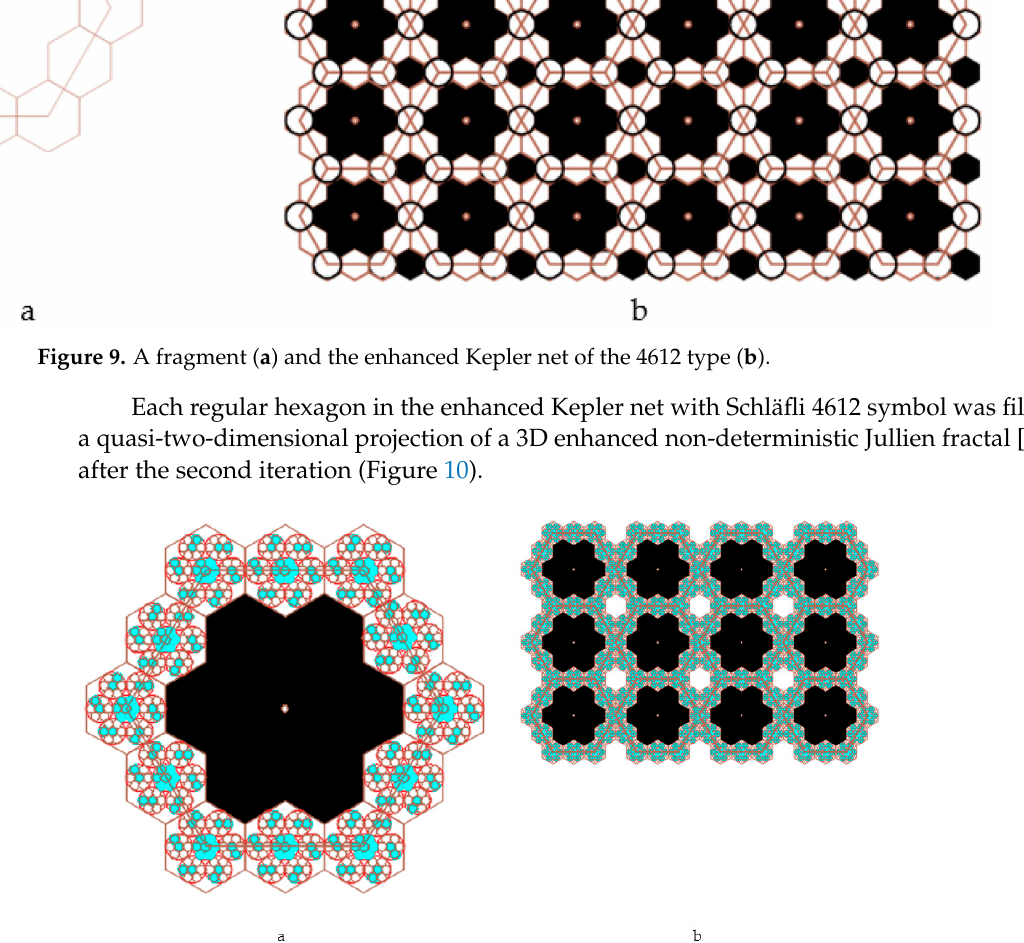
Figure 10. A fragment ( a ) and the enhanced Kepler net of the 4612 type ( b ) with the cells filled with a quasi-two-dimensional projection of the Jullien fractal.